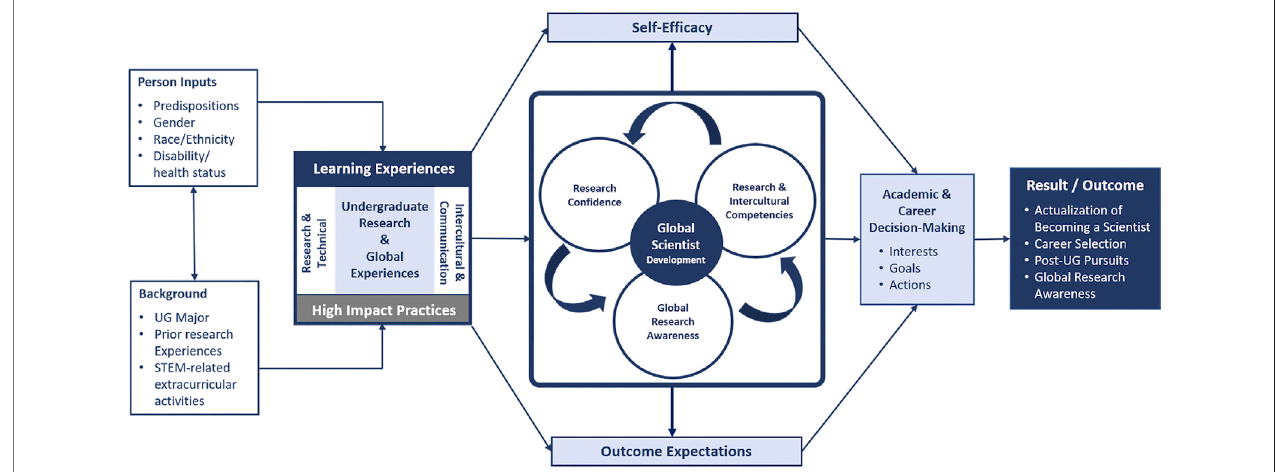
FIGURE 3 | A Conceptual Model Integrating Social Cognitive Career Theory, Science Identity, and Intercultural Competencies and Awareness to promote the development of undergraduates at Global